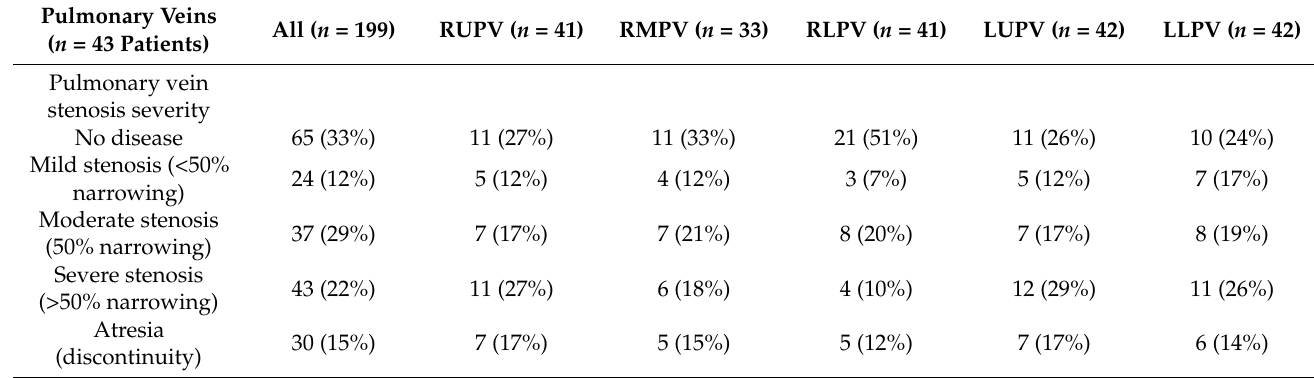
Table 3. Individual pulmonary vein and lung segment characteristics by CT (N = 199 veins; 202 lung segments). Data expressed as N (%) or median (IQR)